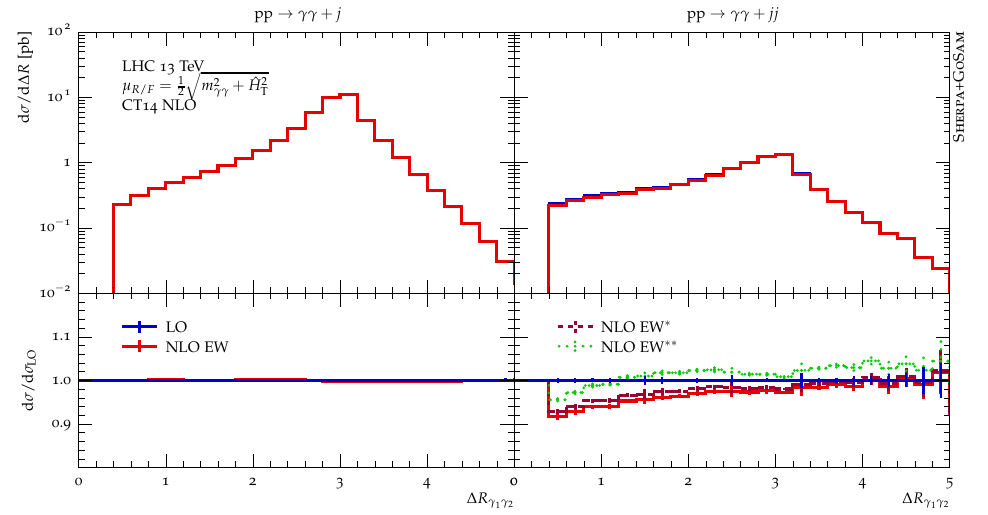
Figure 6 . Angular separation of the leading and subleading isolated photon system in (cid:13)(cid:13) +1 ; 2 jets production at 13 TeV at the